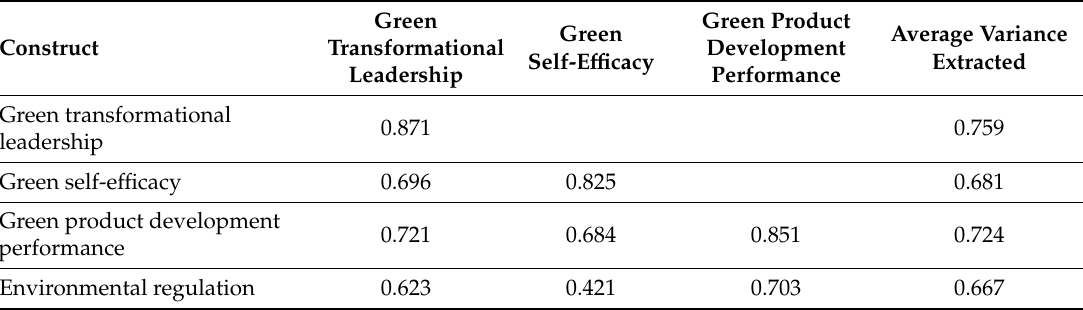
Table 2. Measurement model: discriminant